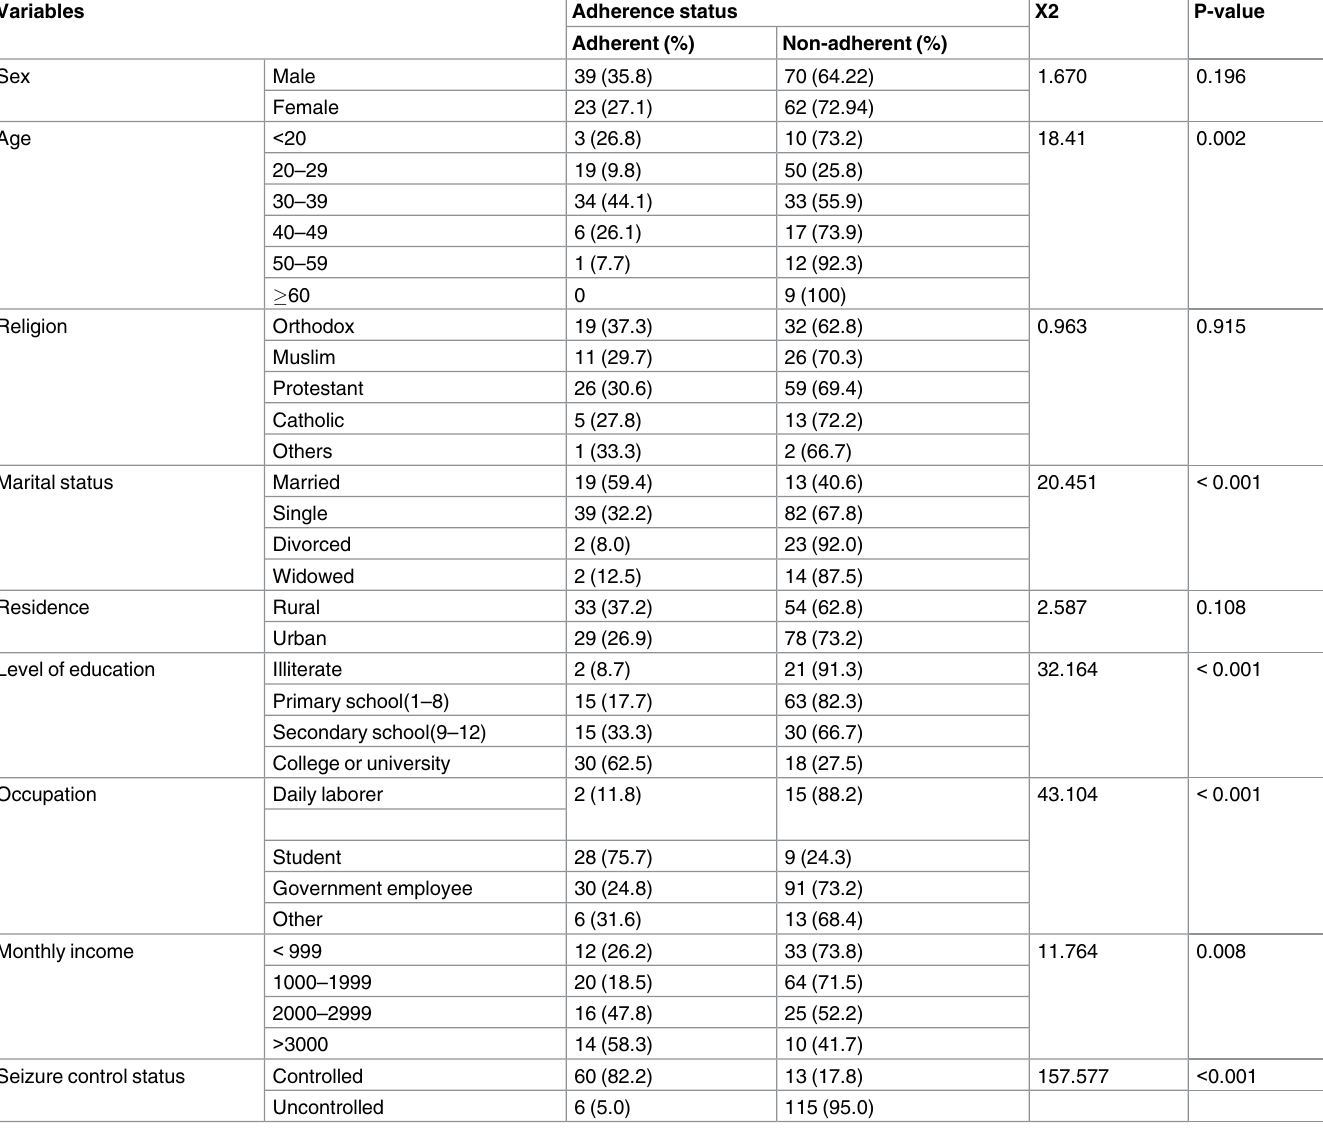
Table 3. The effect of socio-demographic characteristics on adherence of epileptic patients at Yirgalem General